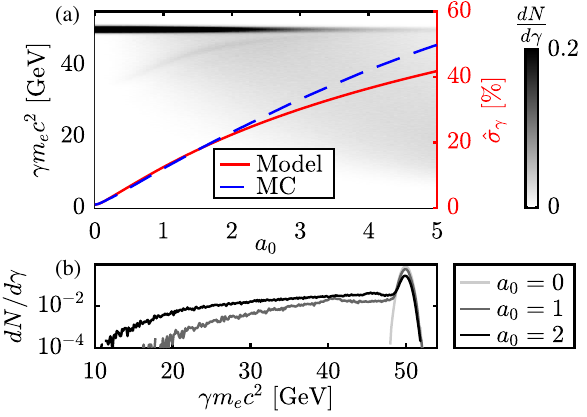
FIG. 4. (a) Electron beam spectrum after 90° collision with a Gaussian laser pulse from Monte Carlo simulations with differing values of a 0 . The initial electron beam had a mean energy of 50 GeV with ¯ σ γ 0 ¼ 1% . The resultant electron beam energy spread was calculated from the results of the Monte Carlo simulation (blue) and the analytical model (red). (b) Plots of the final electron spectrum for selected values of a 0 .